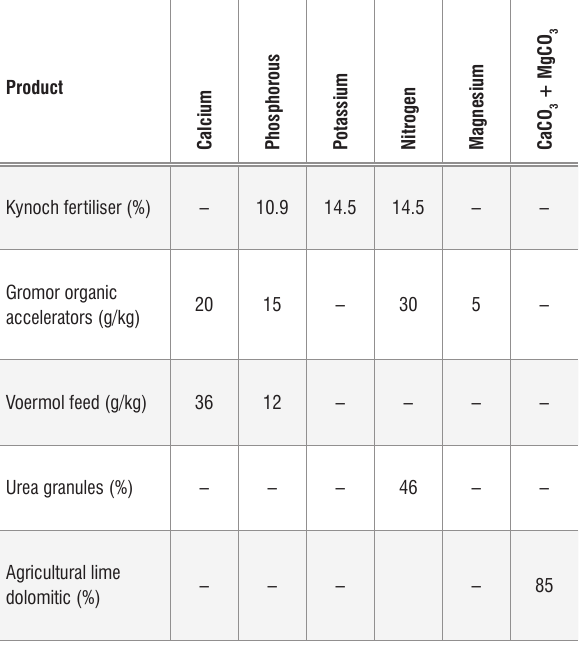
Typical composition of agrochemicals popularly used by farmers in the Underberg area